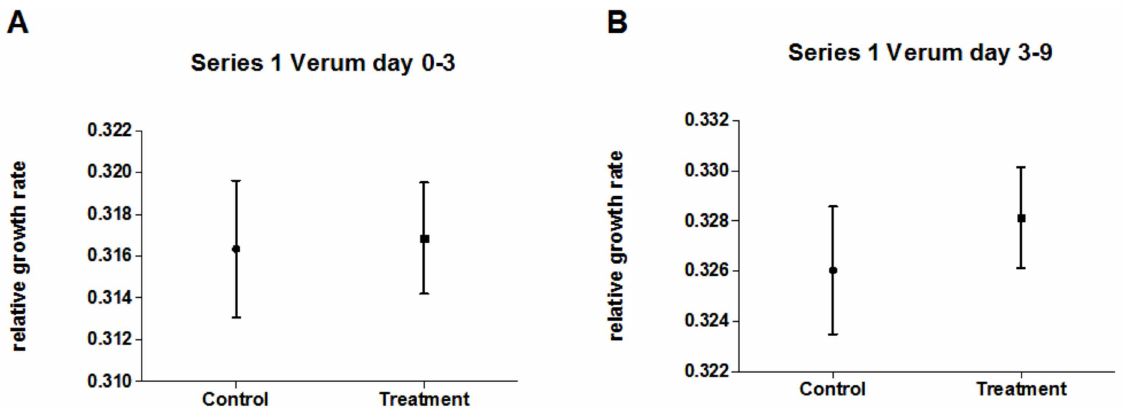
Figure 5. Mean relative growth rate ( ± 95% CI) of duckweed treated with either potentised As 2 O 3 (potency levels 17x–18x, 21x–23x, 28x, 30x, 33x, numerically pooled, n = 200) or water as control (unsuccussed and succussed water samples, numerically pooled, n = 170) in the 5 independent experiments of series 1. ( A ) Early time period (day 0–3), ( B ) Late time period (day 3–9).